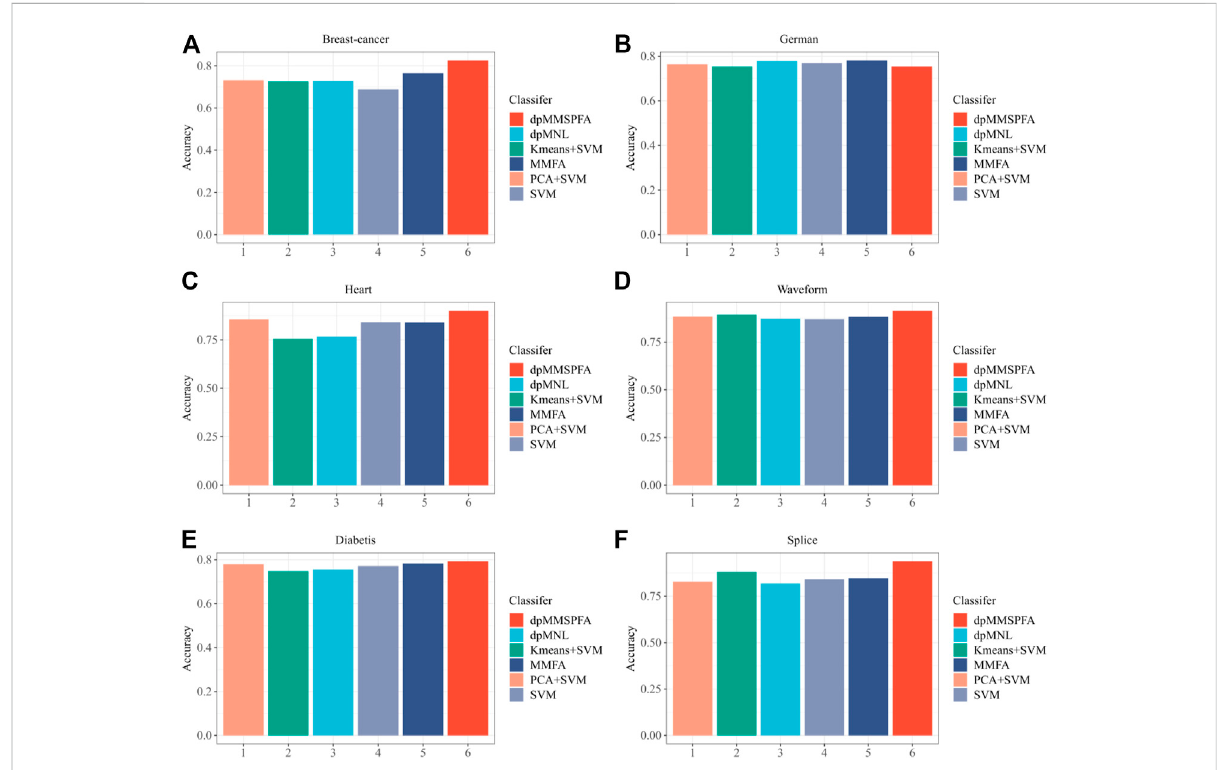
FIGURE 3 Test accuracies of different models (A) Breast-cancer; (B) German; (C) Heart; (D) Waveform; (E) Diabetis; (F)